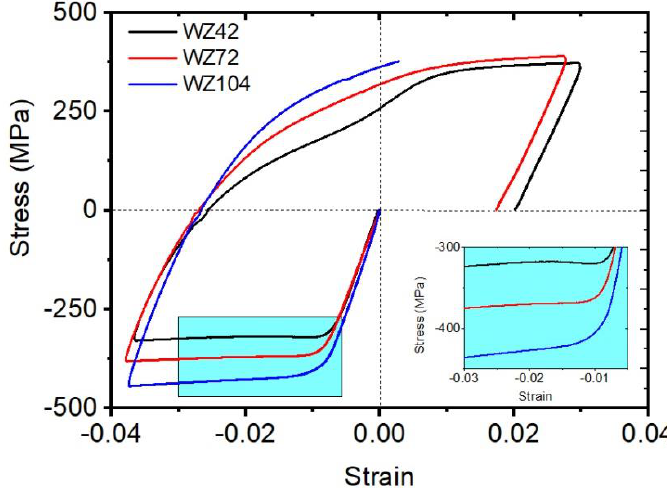
Figure 2. The deformation curves for the one-cycle deformation of the Mg-LPSO alloys. The microstructures of the alloys after the full-cycle deformation are presented in Figure 3. In the WZ42 alloy, cracks in the LPSO lamellae formed during straining are observed, Figure 3a. Kinking is characteristic for the WZ72 and WZ104 alloys, Figure 3b,c. The result of high twinning activity in WZ42 alloy can be spotted on the image quality (IQ) maps in Figure 3d. There is a relatively high number of leftover twin boundaries (highlighted by the red color). The twin boundaries are identified as extension {1012} 1011